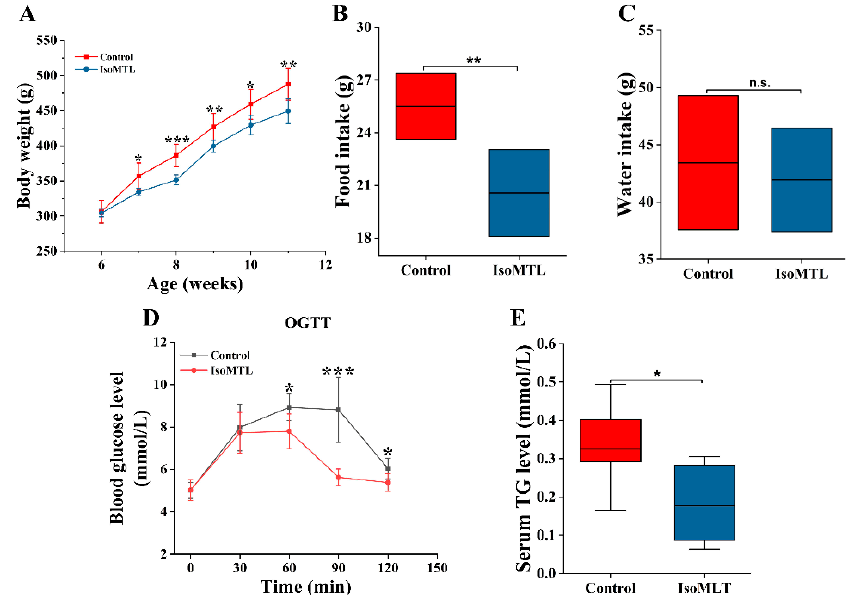
Figure 1. Dietary isomaltulose affects physiological and biochemical parameters in rats. ( A ) Body weight. ( B ) Food intake and ( C ) water intake. ( D ) The effect on oral glucose tolerance (OGTT). ( E ) The effect on triglyceride (TG). n.s. refers to no significant difference between two groups. * Represents differences between two groups (* p < 0.05, ** p < 0.01, *** p < 0.001).